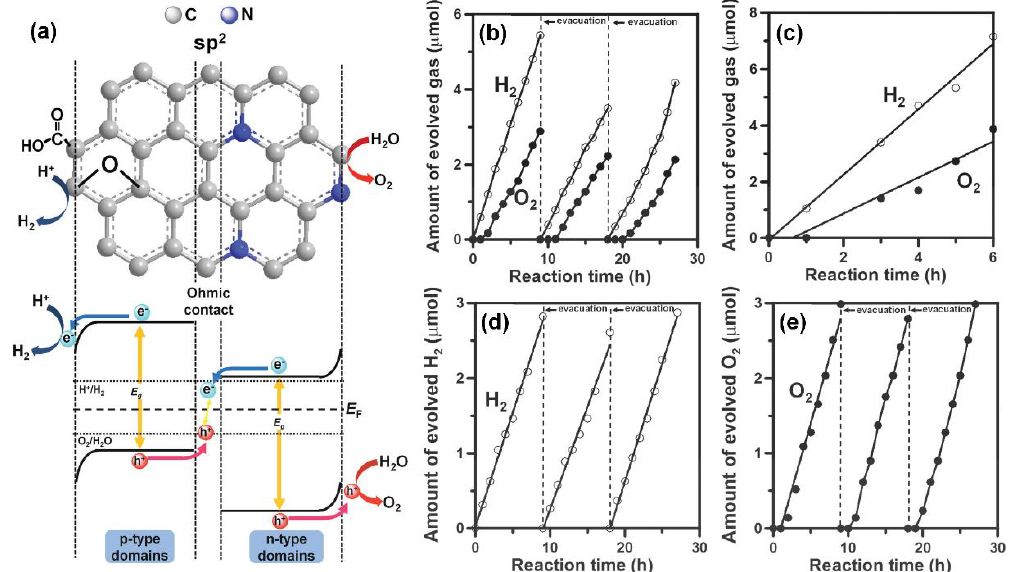
Figure 8. ( a ) Schematic illustration of the configuration and energy diagram for a NGO–QD photochemical diode. Visible light induced photocatalytic water splitting performance over different photocatalysts: ( b ) 1.2 g of NGO–QDs, ( c ) 0.5 g of Rh 2 − y Cr y O 3 / GaN:ZnO, ( d ) 1.2 g of GO–QDs, ( e ) 1.2 g of NH 3 –NGO–QDs. Adapted with permission from Reference [138]. Copyright (2014)